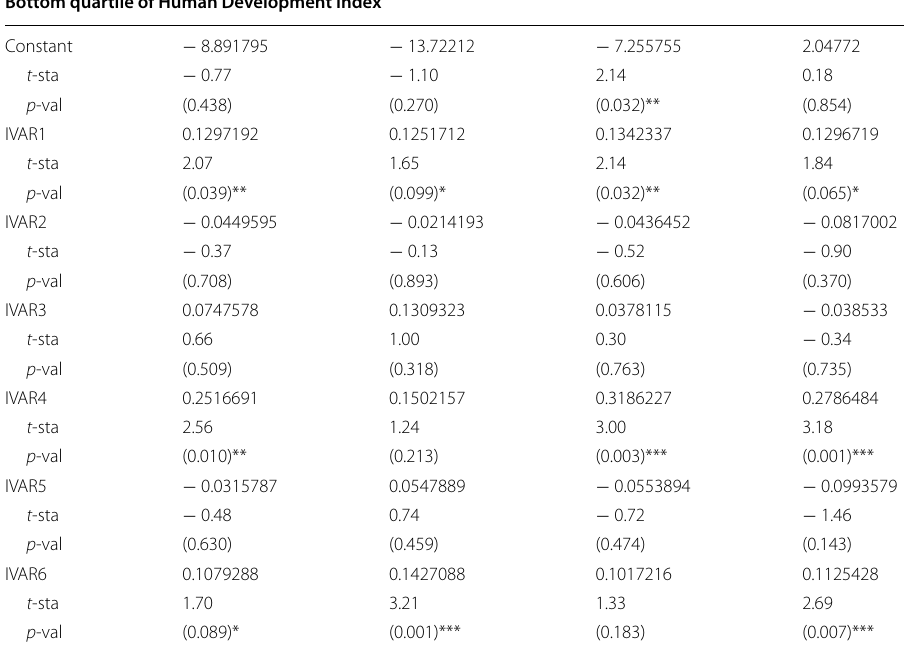
Bottom quartile of Human Development